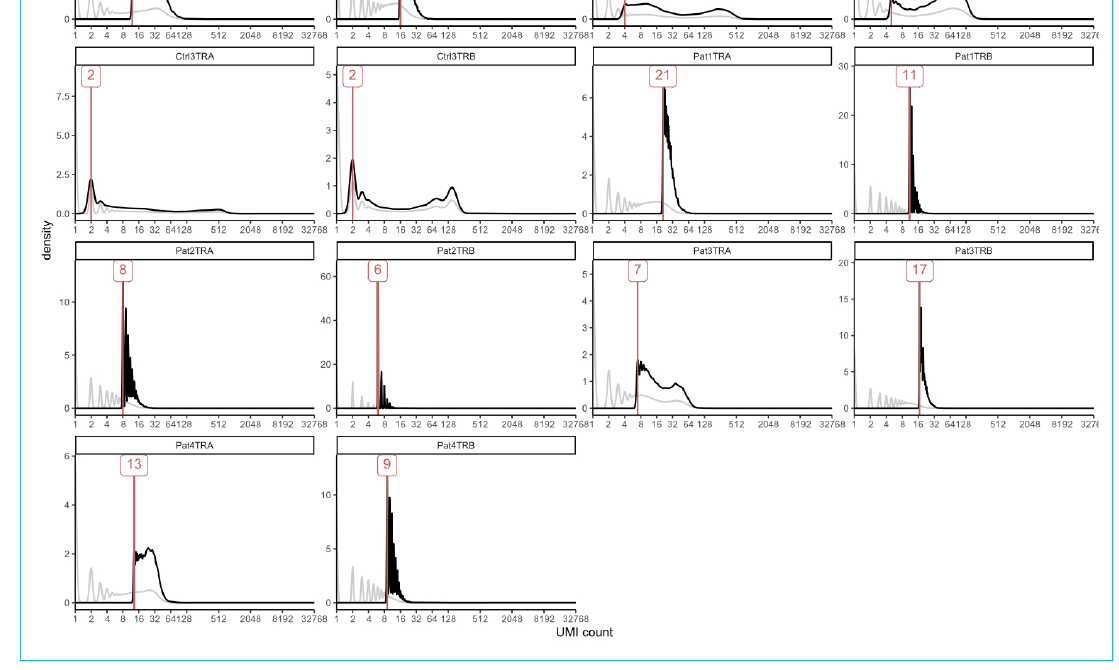
Figure S2: V and J gene usage